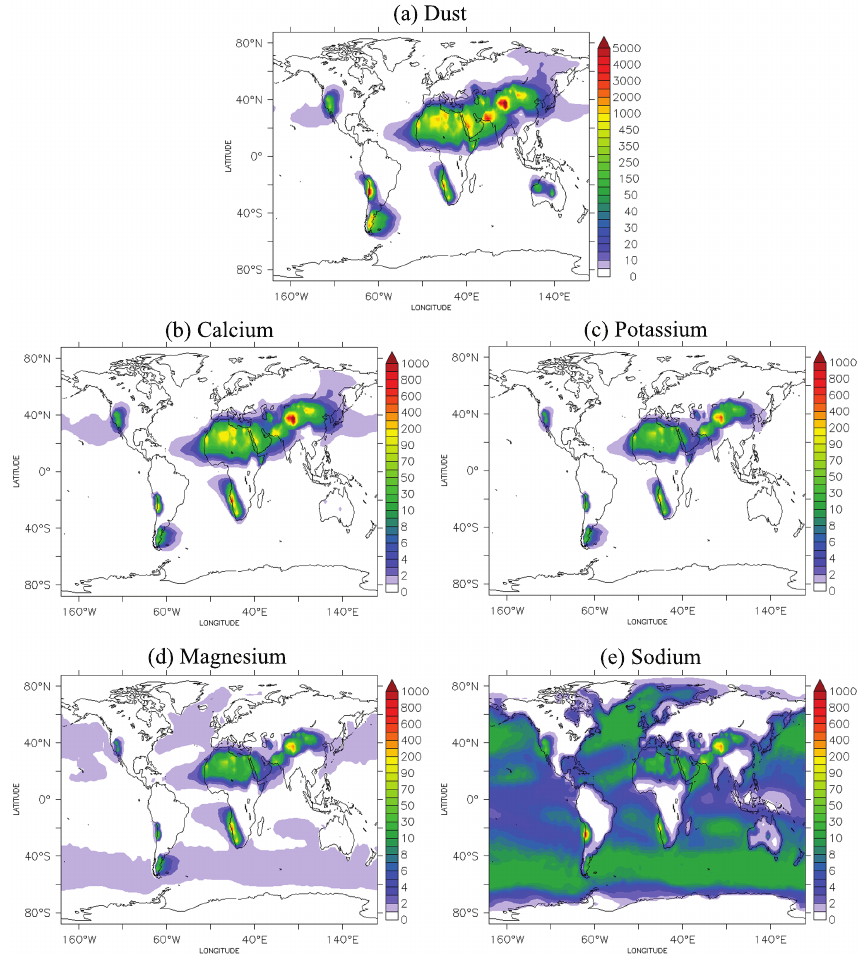
Figure 2. Predicted average near-surface concentrations (in µgm − 3 ) of (a) inert dust, (b) calcium, (c) potassium, (d) magnesium and (e) sodium during the years